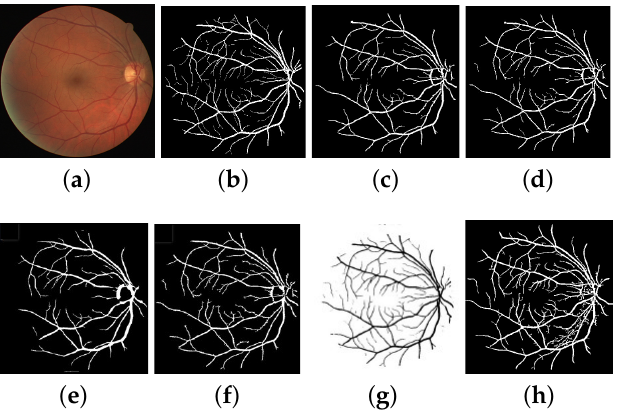
Figure 11. This figure shows the comparative analysis of the detection of tiny vessels from a retinal image with our proposed method. Fig ( a ) shows the original image. Fig ( b ) shows the manually seg- mented image. Fig ( c ) shows the output image of Nuygen’s method. Fig ( d ) shows the output image of Hou’s method. Fig ( e ) shows the output image of Zhao’s method based on filtering. Fig ( f ) shows the output image of Zhao’s method based on wavelet transform filtering. Fig ( g ) shows the output image of Yan’s method based on filtering. Fig ( h ) shows the output image of the proposed method. Table 7. Comparison of Proposed Method with Existing